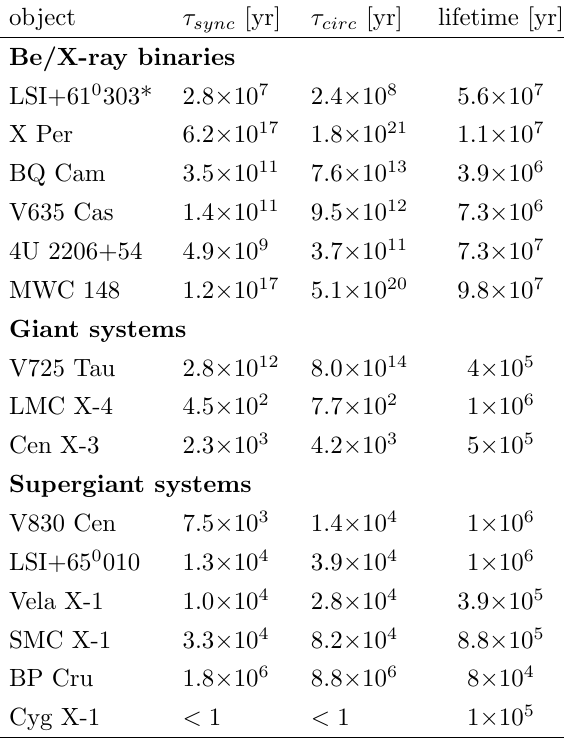
Table 1: Calculated time scales. Given here are the name of the object, synchronization time scale, circu- larization time scale, and the lifetime.